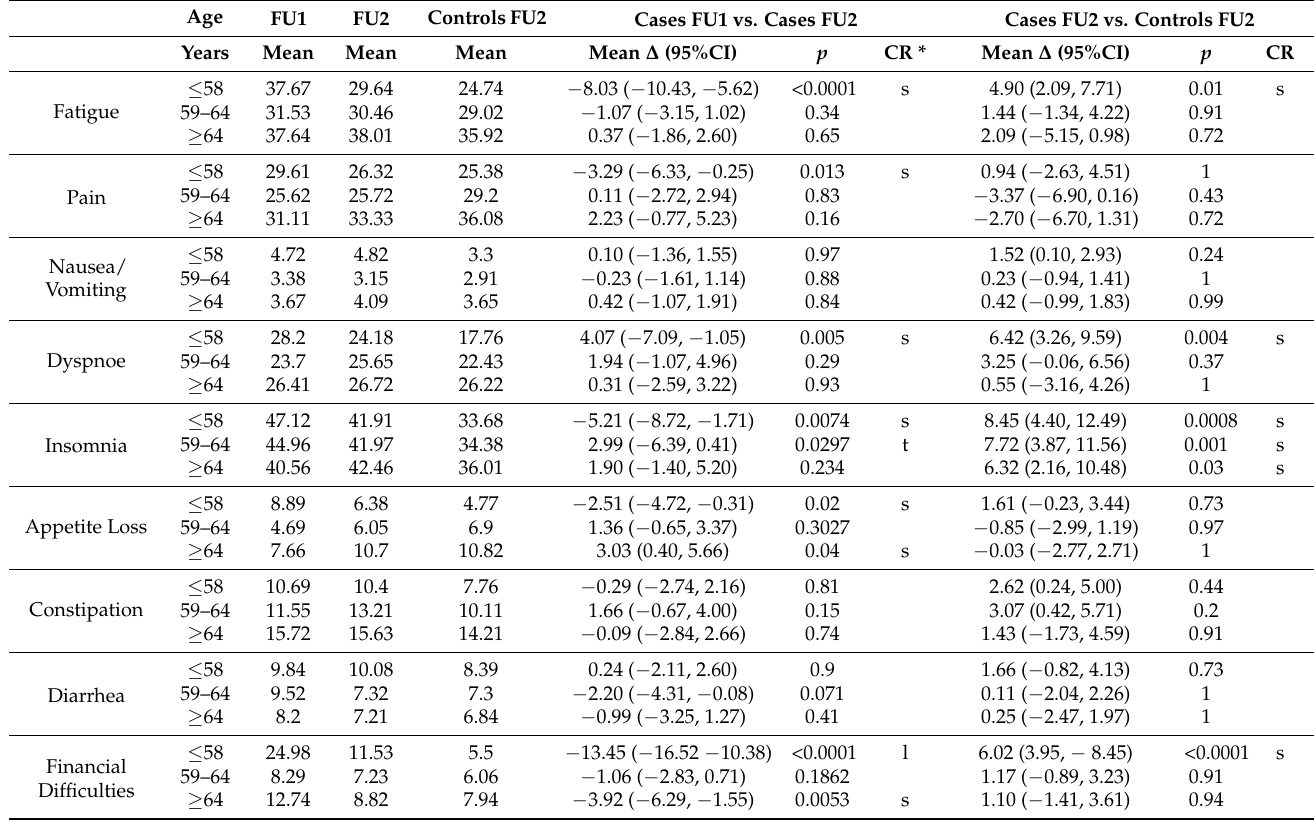
Table 4. Symptoms of breast cancer survivors at FU1 and FU2 stratified by age and compared to healthy controls at FU2. FU1 FU2 Controls FU2 Cases FU1 vs. Cases FU2 Cases FU2 vs. Controls